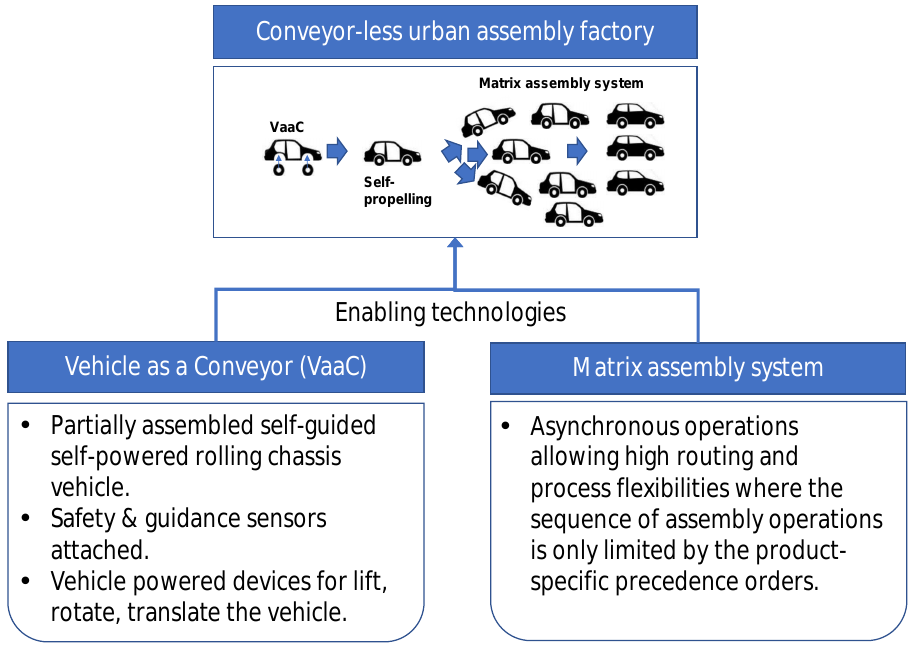
Figure 2. Enabling technologies for conveyor-less car assembly factories in cities: VaaC and matrix assembly system.